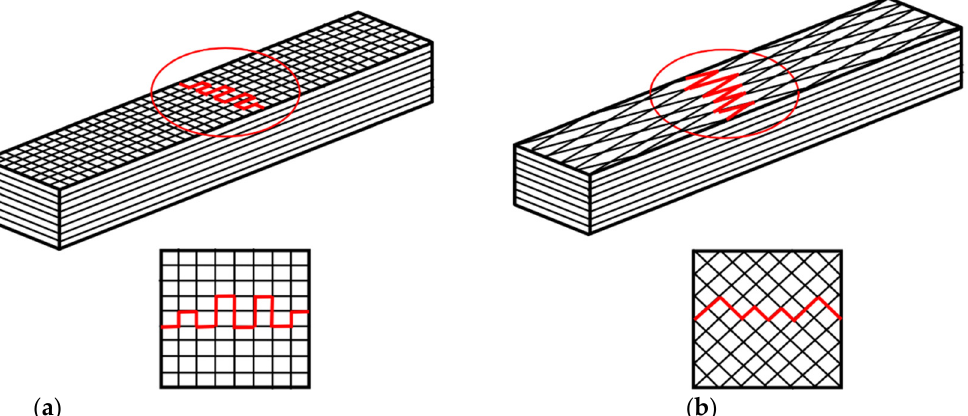
Figure 11. The fracture characteristics of the studied hybrid composites: ( a ) [0°/90°] 4s ; ( b ) [ − 45°/45°] 4s.